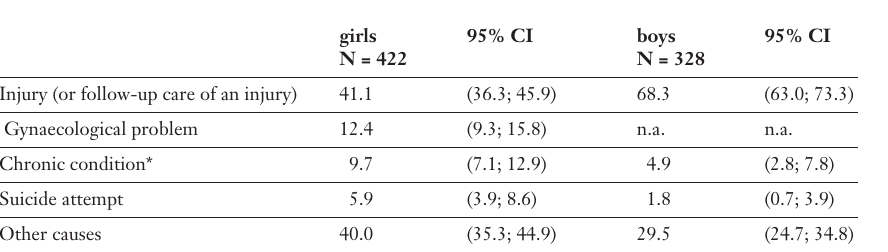
Reasons for hospital- isation among ado- lescents hospitalised over the last 12